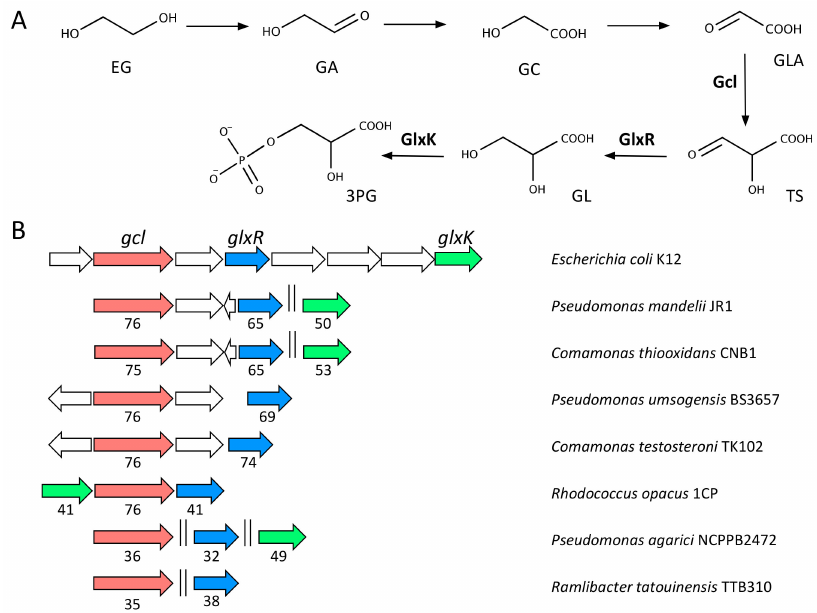
Figure 4. ( a ) EG metabolism via GLA. The GLA canonical pathway described in the text is shown. The 3-phosphoglycerate (3PG) produced is later funnelled into the central metabolism via acetyl-CoA. The names of the molecules and abbreviations are: ethylene glycol, EG; glycoladehyde, GA; glycolate, GC; glyoxylate, GLA; tartronate semialdehyde, TS; glycerate, GL. ( b ) Genetic organisation of the genes involved in GLA metabolism identified in several genomes available in databases. Numbers below arrows indicate the percentage of identity compared to the orthologous genes present in E. coli K12 (accession: AP009048; [67]). Plots were produced with SyntTax (http: // archaea.u-psud.fr / SyntTax;